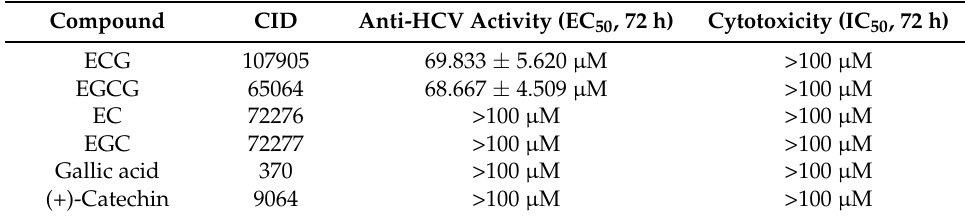
Table 4. Anti-HCV activity of major components of S. suberectus . The anti-HCV activity and cytotoxicity were evaluated in Huh-luc/neo-ET cells for 72 h treatment and determined as described in the Materials and Methods Section. The results were presented as mean ± S.D. from at least three separate experiments.